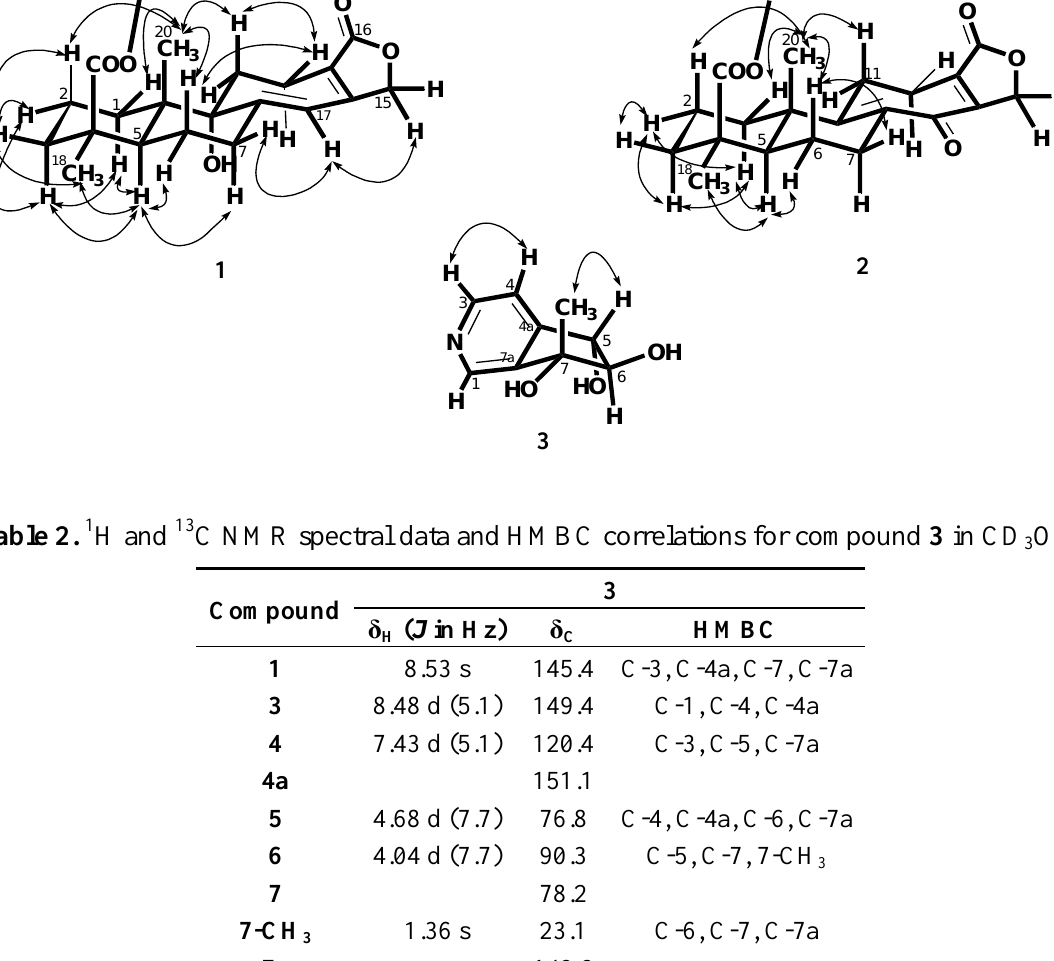
Figure 3. Nuclear overhauser enhancement spectroscopy (NOESY) correlations of 1 – 3 .